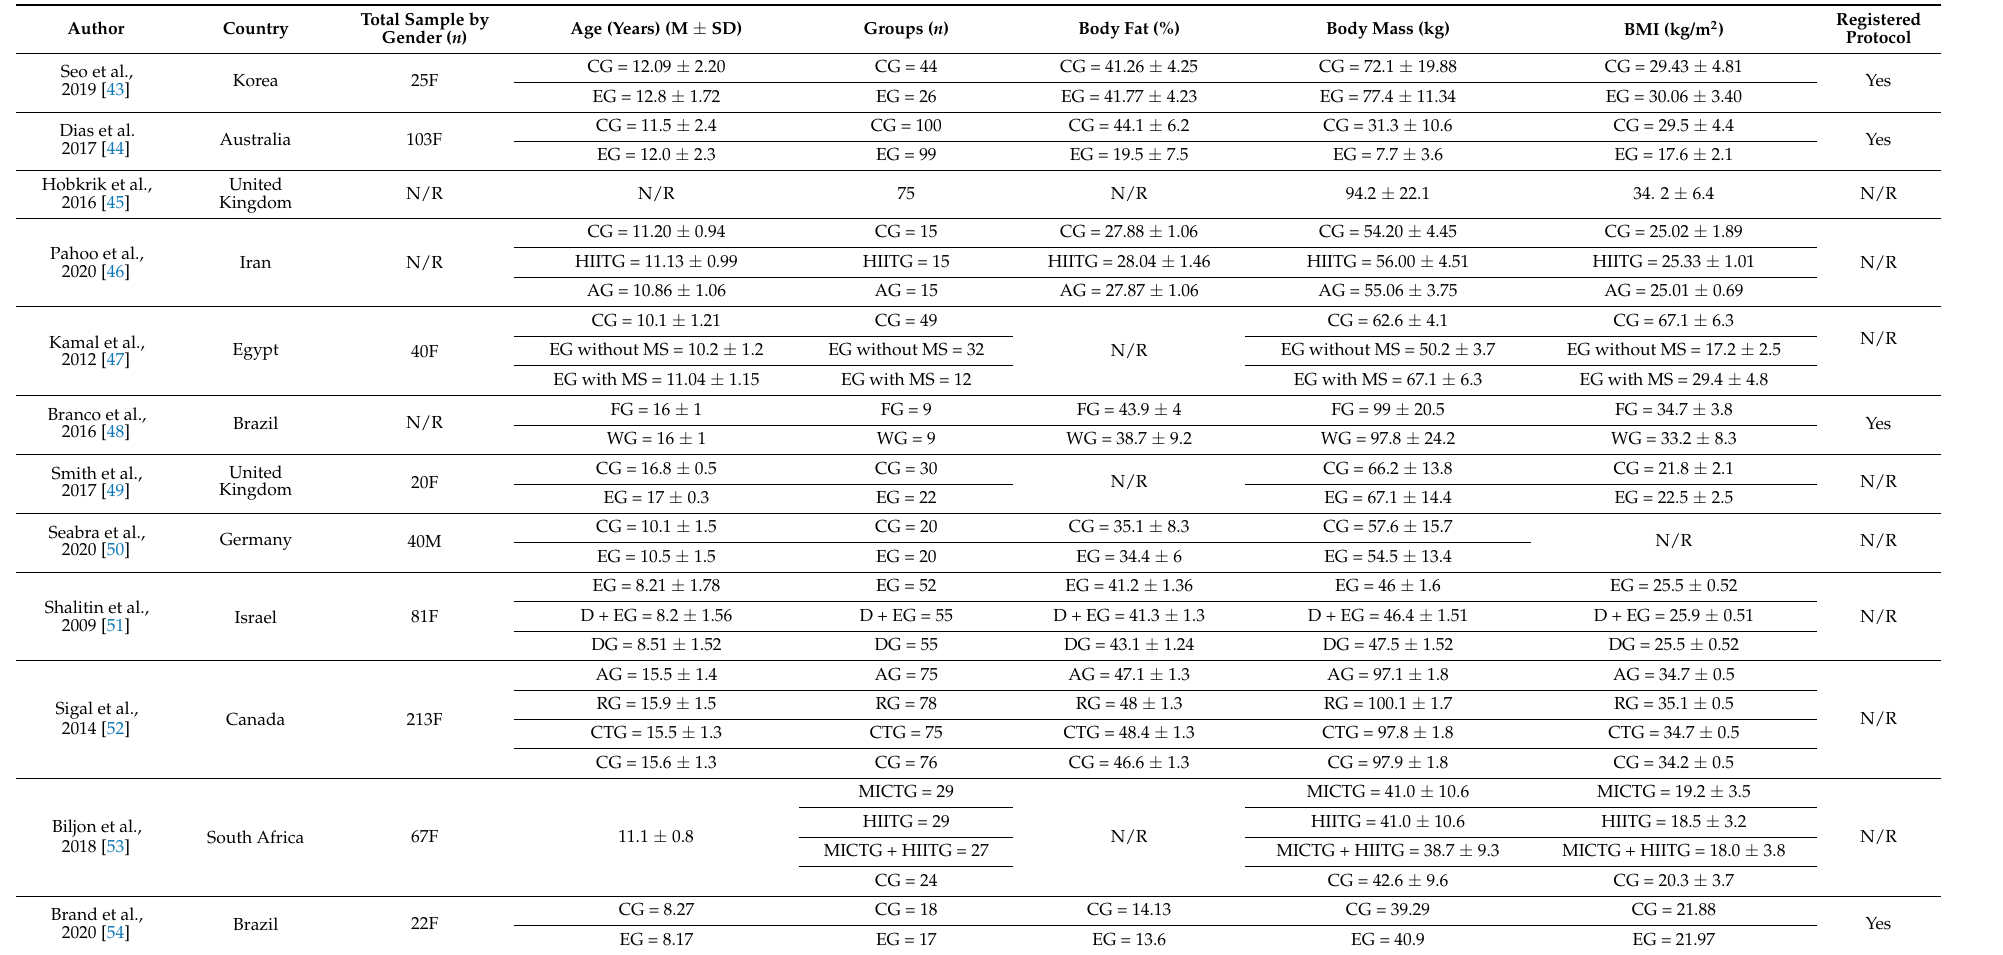
Table 3. Characteristics of the included